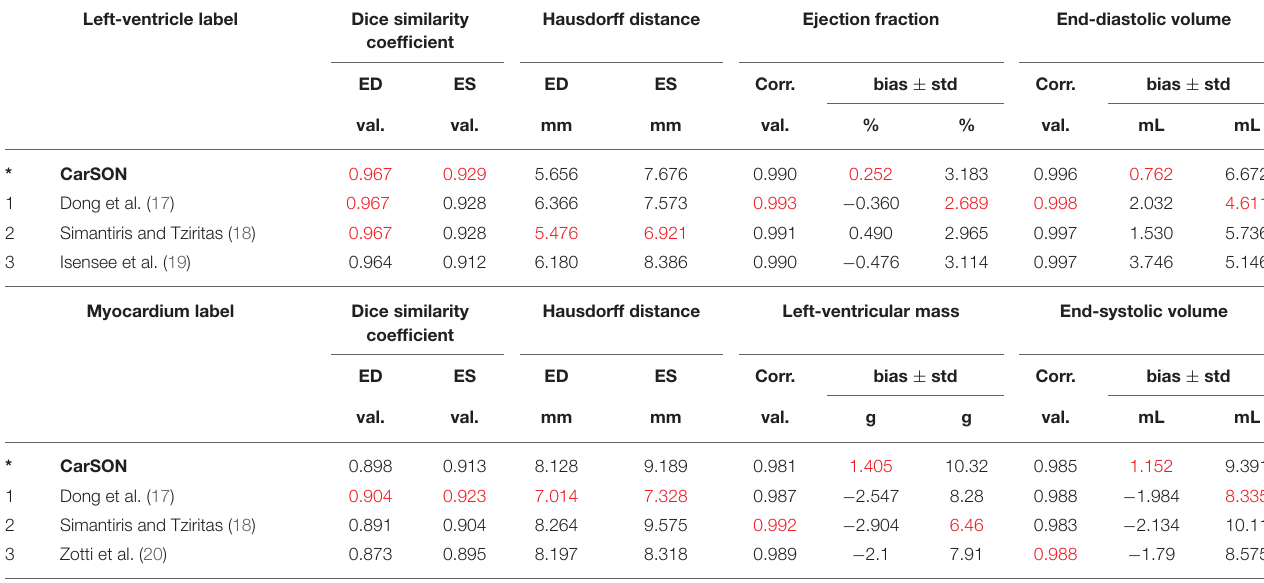
TABLE 1 | State-of-the-art methods for left-ventricular segmentation shown at end-diastole (ED) and end-systole (ES) on the ACDC test set compared to proposed approach. Left-ventricle label Dice similarity Hausdorff distance coefficient